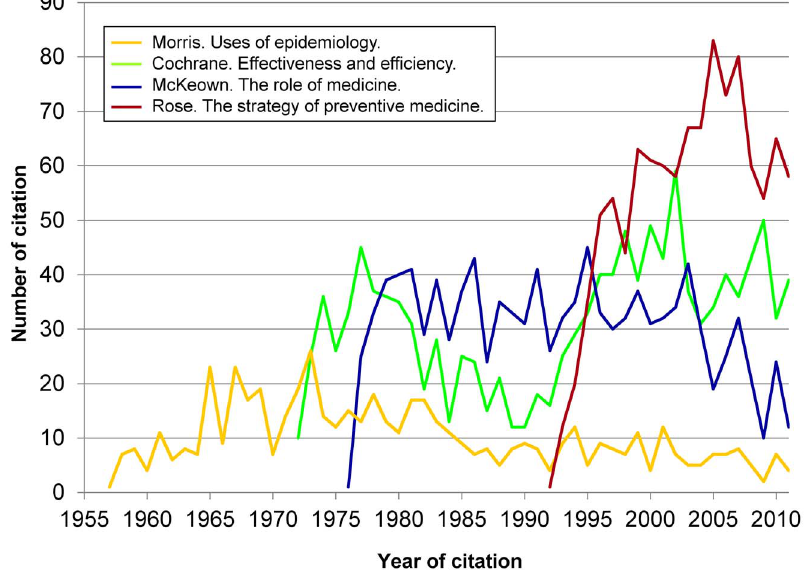
Figure 8. Citations to 4 books on concepts, theory and policies (total, 3,986 citations).